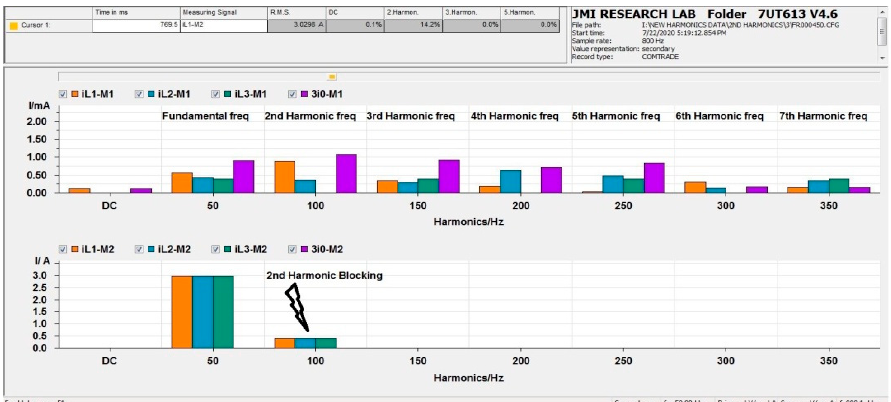
Figure 14. 2nd HB at 3000 mA Rated current & 15% of Inrush current condition.